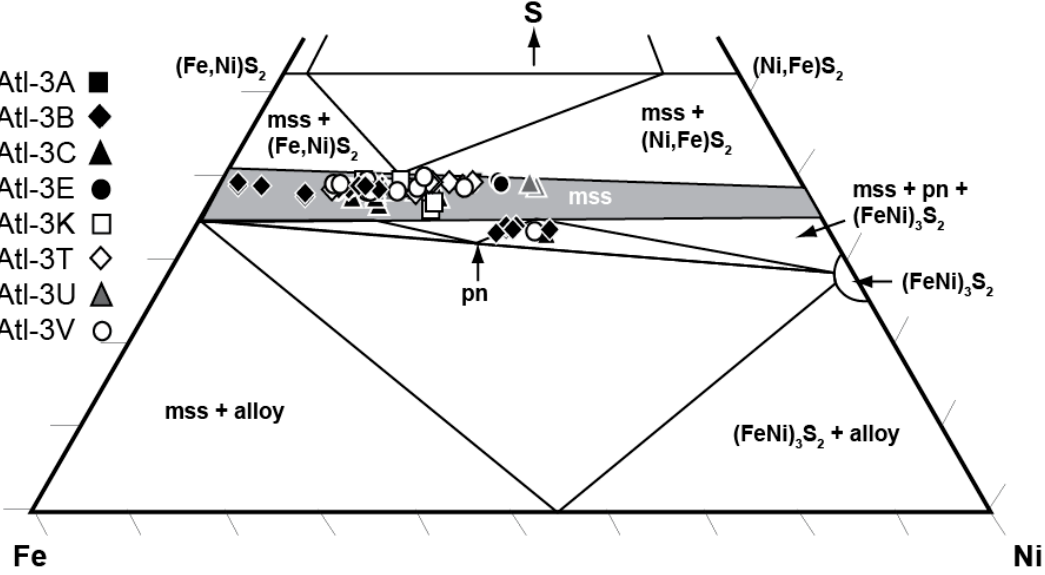
Figure 2. Composition of mss from Middle Atlas mantle xenoliths shown in the ternary system Fe-Ni-S at 600 °C [38]. Pentlandite is abbreviated to pn.